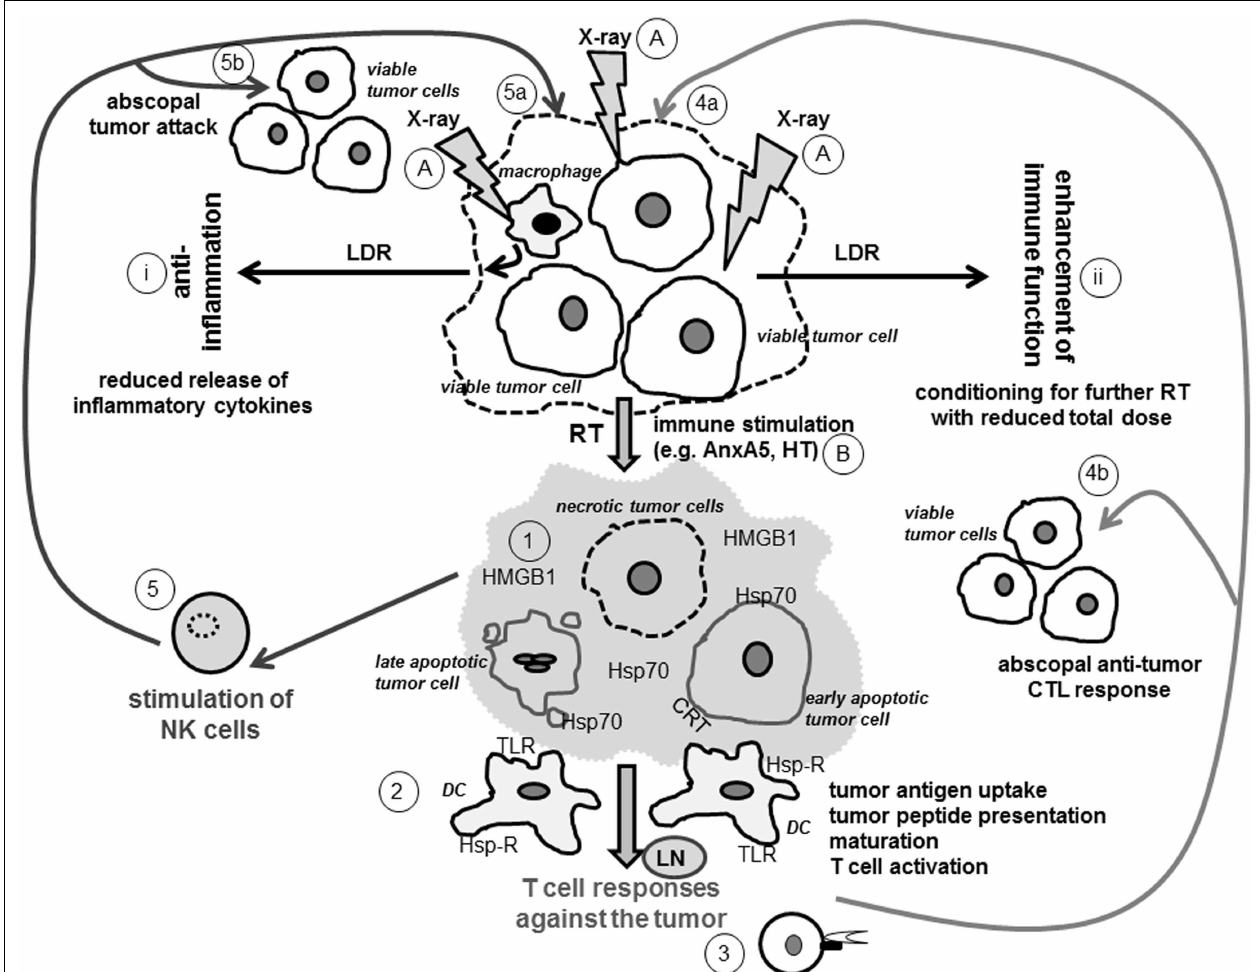
uptake of apoptotic tumor cells by macrophages is blocked with AnxA5 (B). The distinct forms of dying and dead tumor cells create an immune antigens and (cross-) present tumor peptides via MHC class I and class II molecules to CD8 + and CD4 + T cells, respectively (3). CD8 + CTLs recognize ones (4b).The tumor microenvironment and the tumor cells resulting from RT and further immune stimulation may further directly activate NK cells (5) against the tumor (5a and b). Abbreviations: AnxA5, AnnexinA5; CRT, calreticulin; DC, dendritic cell; Hsp70, heat shock protein 70; Hsp-R,